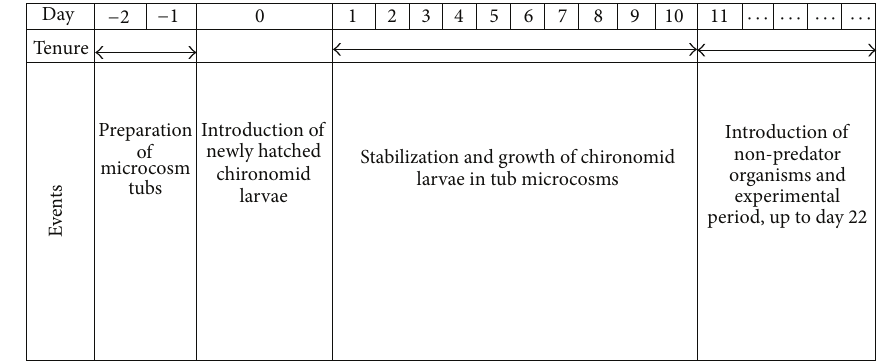
Figure 1: Flow chart explaining the chronology of the experimental design.